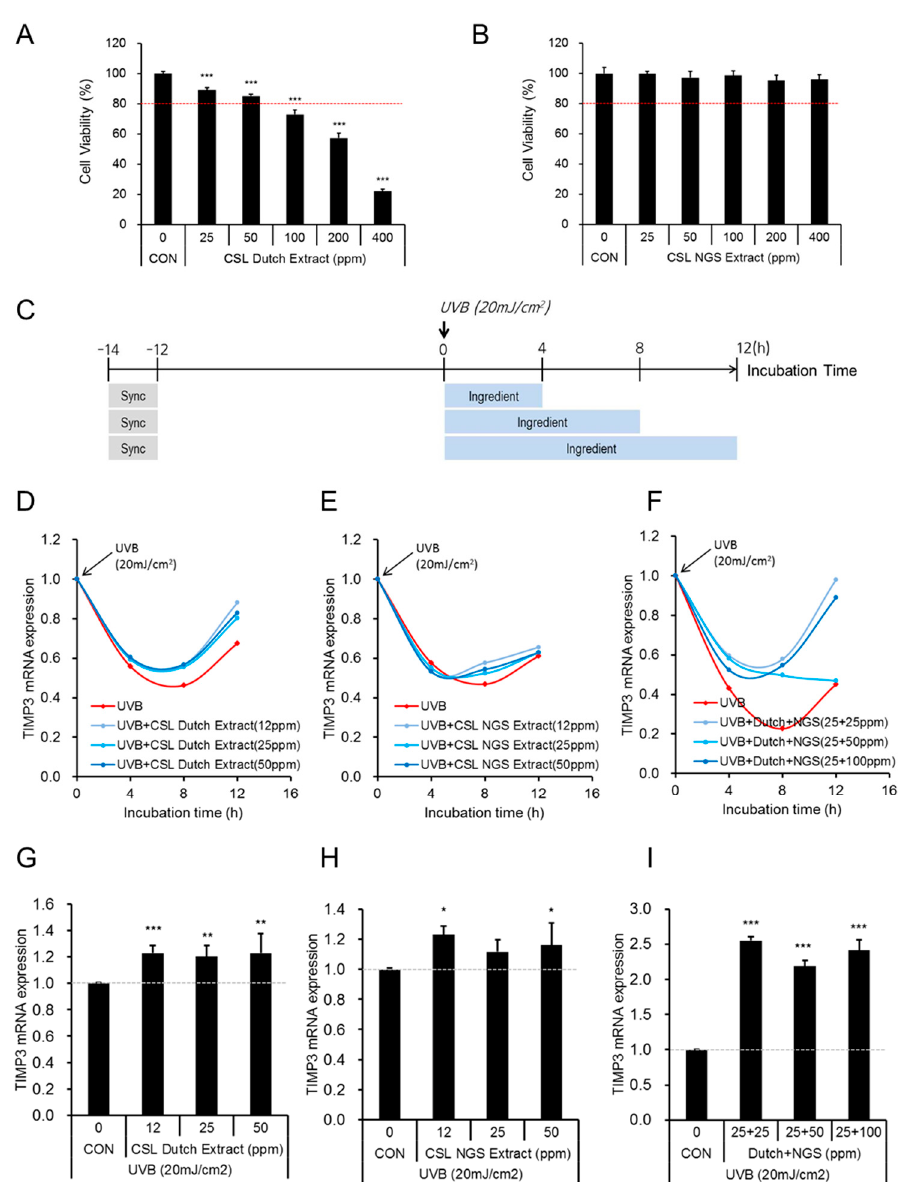
Figure 4. The effects of green tea extracts on down-regulated TIMP3 mRNA expression in UVB-exposed human epidermal keratinocytes. For the cytotoxicity assay, NHEKs were incubated with 25–400 ppm of CSL Dutch extract ( A ), or 25–400 ppm of CSL new green solvent (NGS) extract ( B ), for 16 h. The data is presented as the mean ± S.D. of four replicates; *** indicates p < 0.001; CON indicates control; CSL indicates Camellia sinensis leaves; ( C ) A schematic flow chart of the experimental design to examine the effect of CSL extracts; Sync indicates synchronization; ( D – F ) After exposure to 20 mJ/cm 2 of UVB, NHEKs were treated with CSL Dutch extracts ( D ), CSL NGS extracts ( E ), and Dutch + NGS extracts together ( F ), at the indicated doses and time periods. The expression of TIMP3 mRNA in each treatment was quantified by quantitative real-time PCR (qRT-PCR); ( G – I ) Eight hours after the treatments with UVB and CSL extracts, the relative expression of TIMP3 mRNA was compared in Dutch- ( G ), NGS- ( H ), and (Dutch + NGS)-treated ( I ) NHEKs. The data are presented as the mean ± S.D. of three replicates: *, p < 0.05; **, p < 0.01; and ***, p < 0.001.